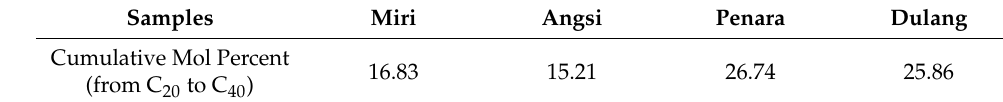
Table 3. Cumulative mol percent from (C 20 to C 40 ) for each sample.